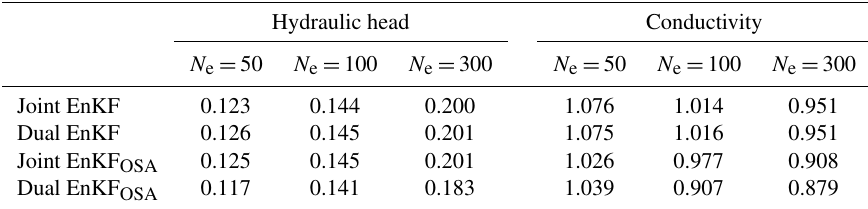
Table 3. Mean average ensemble spread (AESP) of the water head and the hydraulic conductivity for three different ensemble sizes. The reported values are given for the joint EnKF, dual EnKF, joint EnKF OSA , and the proposed dual EnKF OSA . Hydraulic head Conductivity